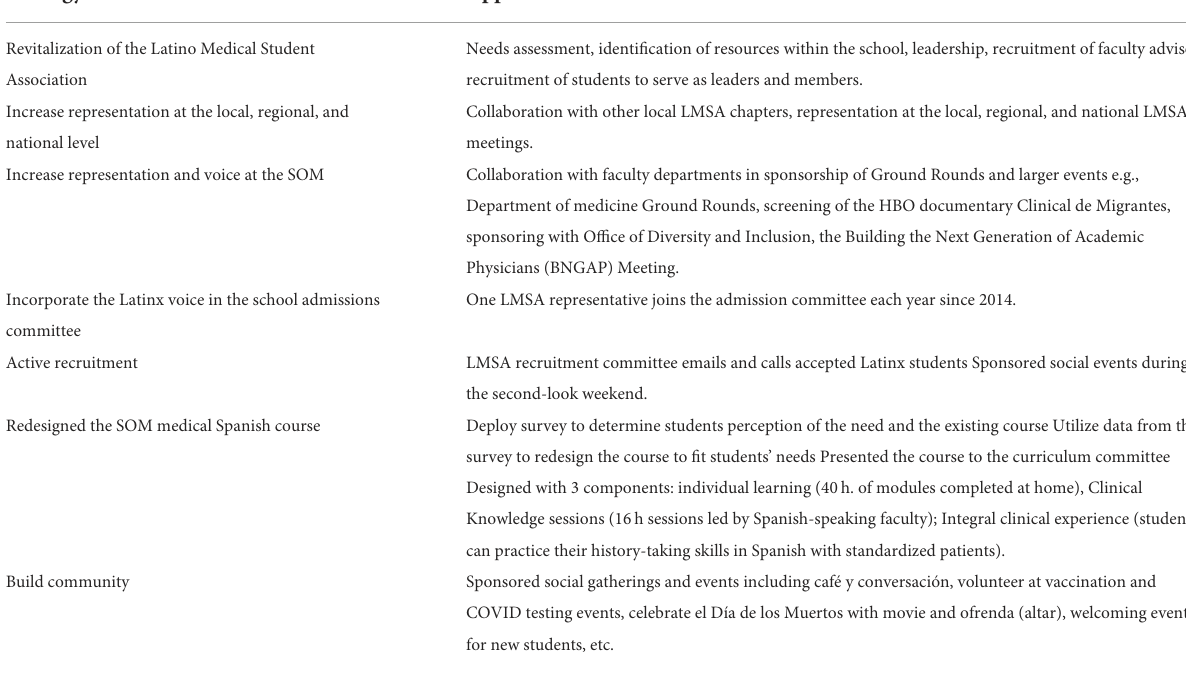
TABLE 1 Strategies implemented to increase Latinx representation at the medical